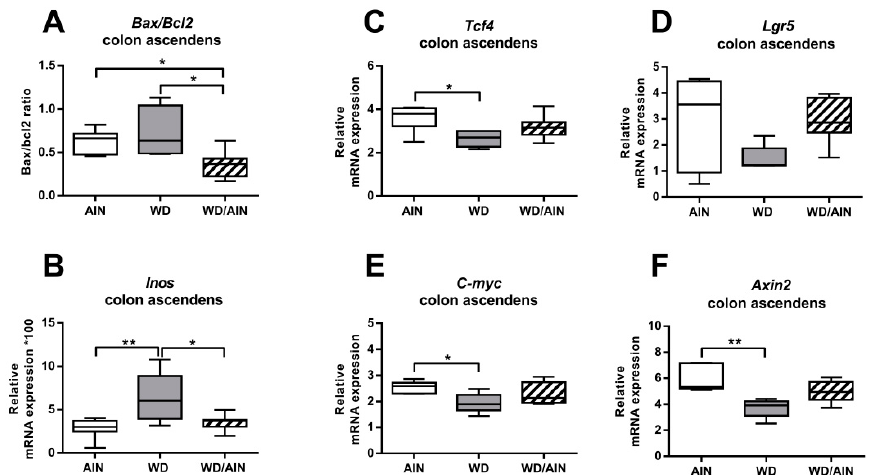
Figure 6. Effect of the diet on the mRNA expression of genes involved in apoptosis, survival, inflammation (A, B) and of genes of the Wnt pathway (C–F) in colon ascendens. n = 4-8 (A-E), n = 5-8 (F) median, interquartile range, and whiskers (min to max); ANOVA with Tukey post-hoc test (A–E) or Kruskal Wallis with Dunn post-hoc test (F), * p < 0.05, ** p < 0.01.